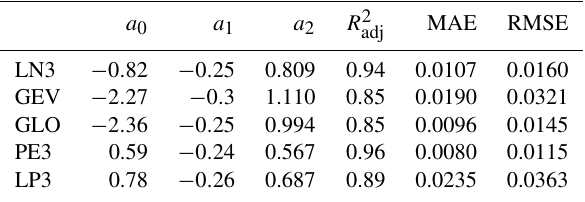
Table 1. Coefficients to be used to estimate ˆ y based on the sample length n and the return period T (Eq. 6) and corresponding regres- sion diagnostics, for different three-parameter fitting distributions (LN3: log-normal; GEV: generalized extreme value; GLO: general-